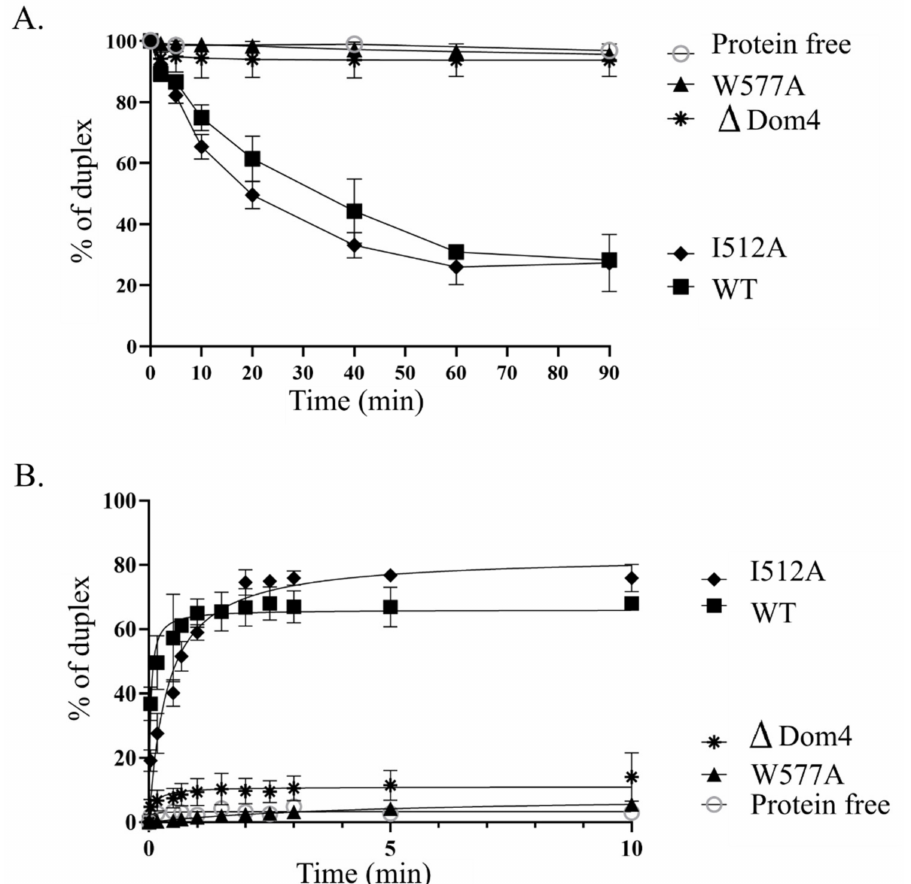
Figure 8. Domain 4 is critical for Tbar -aLhr2 unwinding and strand-annealing activities. ( A ) Kinetics of unwinding reaction (performed as in Figure 7A) of Tbar -aLhr2- ∆ Dom4, Tbar -aLhr2-W577A and Tbar -aLhr2-I512A using the 3 (cid:48) RNA 50 :RNA 26 substrate are shown; ( B ) Kinetics of strand-annealing reactions (performed as in Figure 7B) of Tbar -aLhr2- ∆ Dom4, Tbar - aLhr2-W577A and Tbar -aLhr2-I512A to form 3 (cid:48) RNA 50 :RNA 26 duplexes are